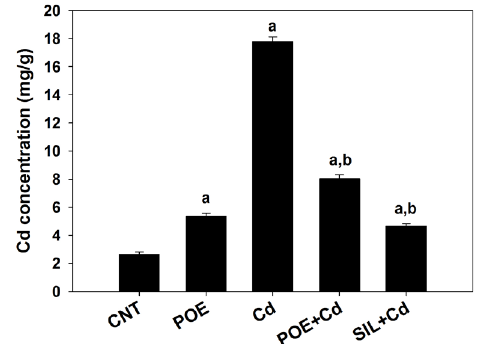
Figure 4. Mitigating effects of POE and SIL treatment on levels of renal Cd in Cd-intoxicated